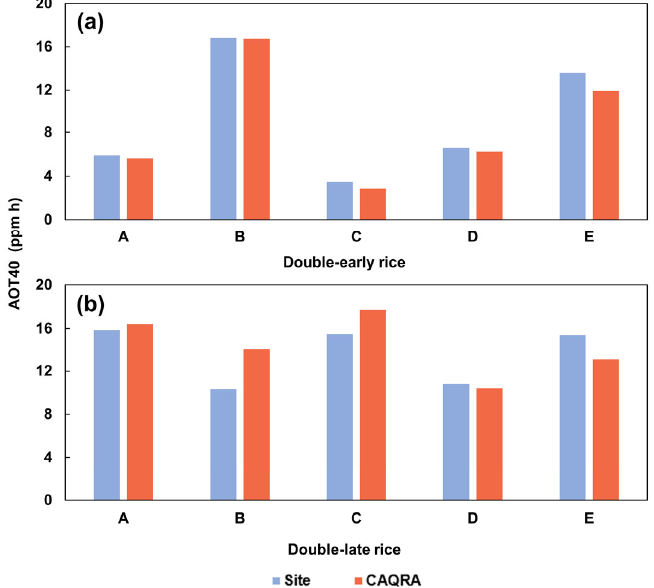
Figure 8. Comparison of AOT40 between rural sites and the used CAQRA ozone reanalysis dataset. ( a ) Double ‐ early rice and ( b ) double ‐ late rice. Note that site A: Tongtianyan, B: Jiaoganghu, C: Zhongshan, D: Qiandaohu and E: Xixi.